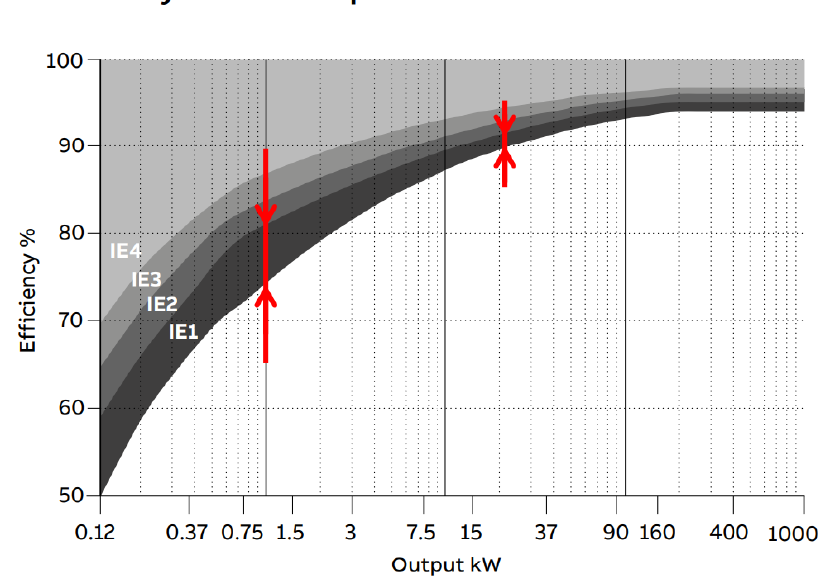
Fig. 13. – IE efficiency classes for electric